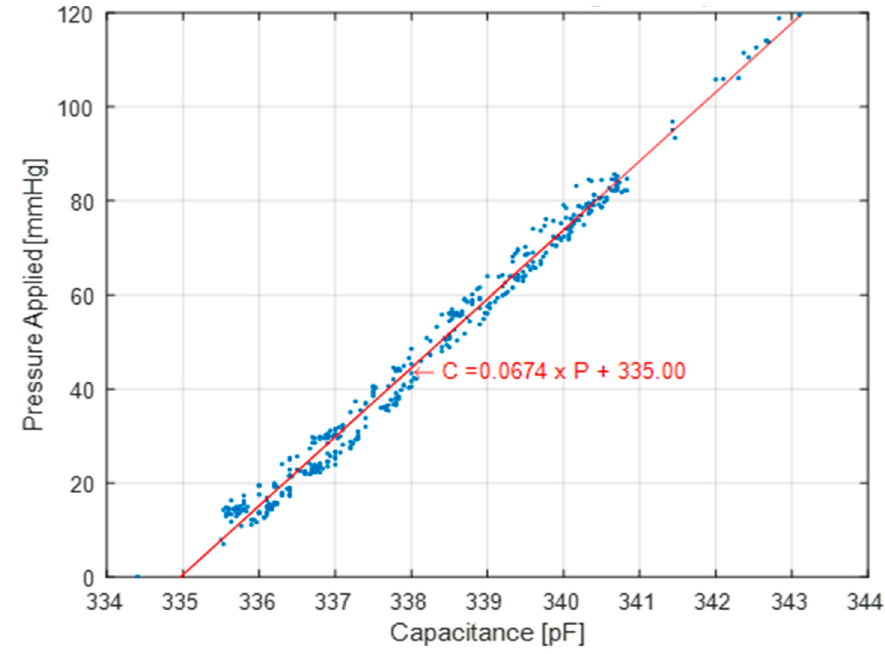
Figure 11. Capacitance change with dynamic pressure application–piston test results.